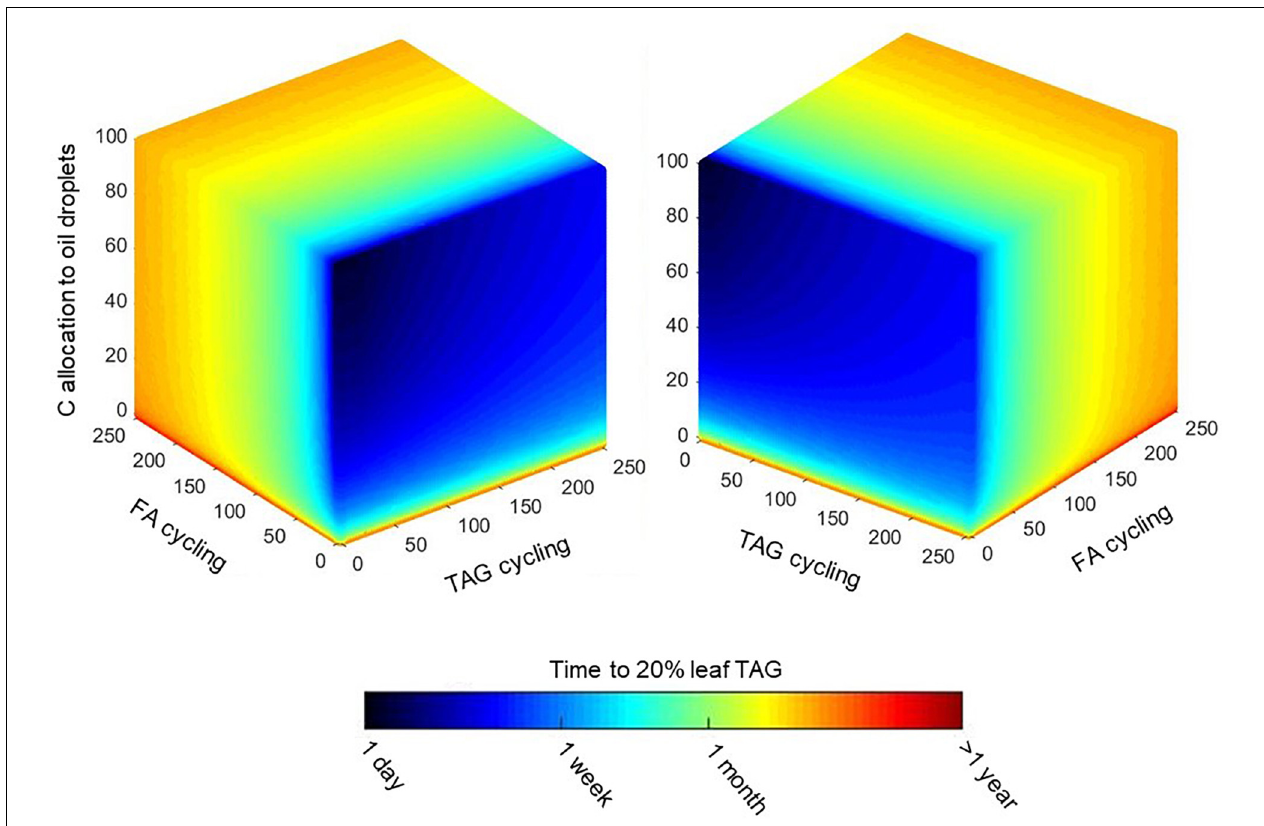
FIGURE 6 | Concurrent effect of allocation and futile cycles on TAG accumulation. Expansion of the Figure 5 simulations to explore how simultaneous variations in net carbon allocation, FA cycling, and TAG cycling affect TAG accumulation in mature Sorghum bicolor leaves. Colors indicate the expected time needed to for stored TAG to occupy 20% (w/dw) of the leaf and are given on a log scale. Cycling units are mol TAG synthesis per mol TAG accumulated in oil droplets (TAG cycling) and mol fatty acid synthesis per mol fatty acid stored in oil droplets (FA